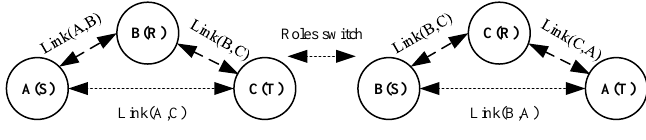
Figure 2. Power transfer roles.